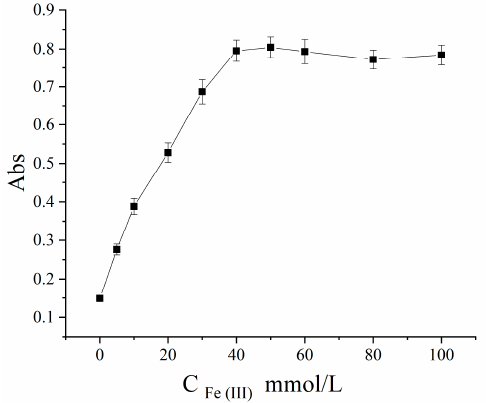
Figure 6. Absorbance curve changed with iron(III) concentration. The SQA concentration: 80 mmol/L.